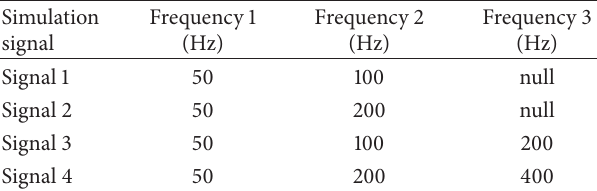
Table 2: Components of four simulation